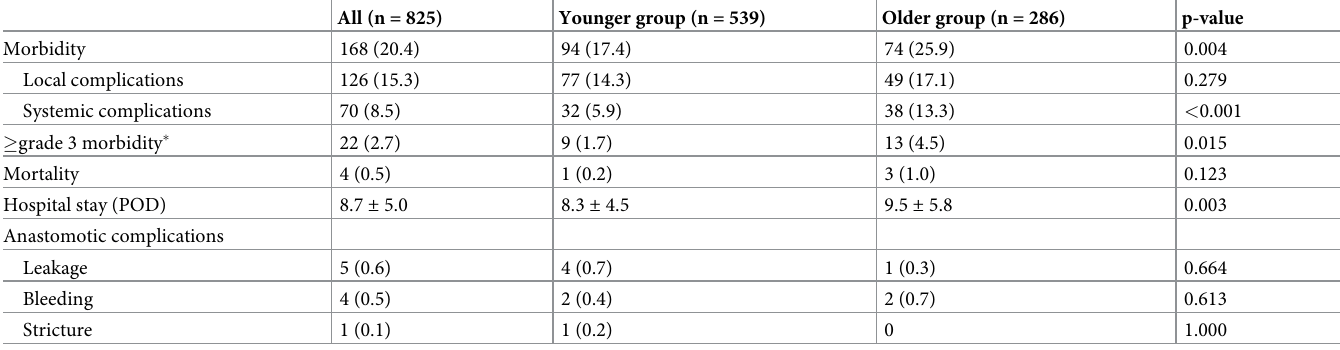
Table 4. Postoperative